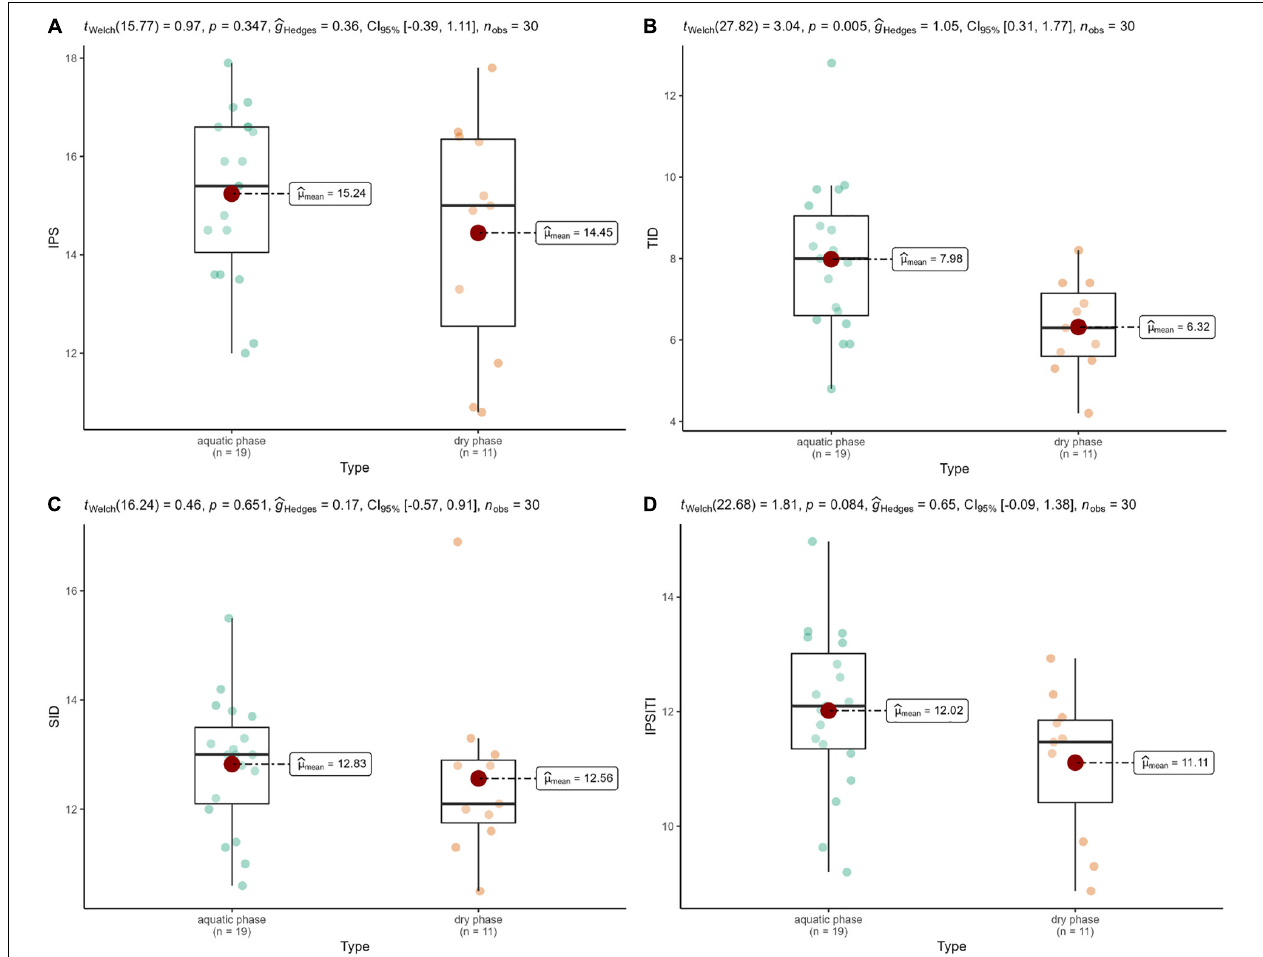
FIGURE 5 | IPS (A) , TID (B) , SID (C) , and IPSITI (D) diatom indices in the dry and aquatic phases. Results of ANOVA tests: p = 0.005 in the case of TID, p > 0.05 in the other